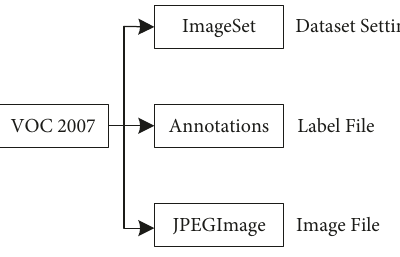
Figure 2: VOC2007 storage